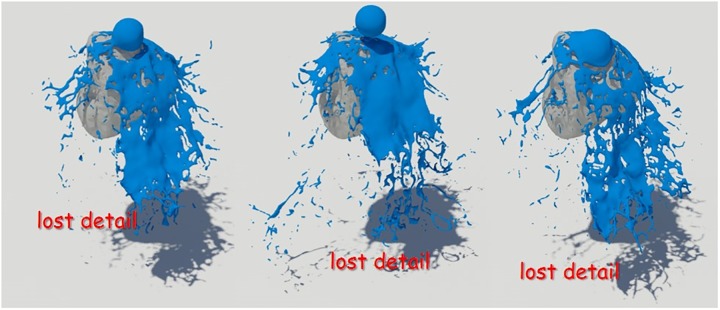
Naive FLIP simulation [21].